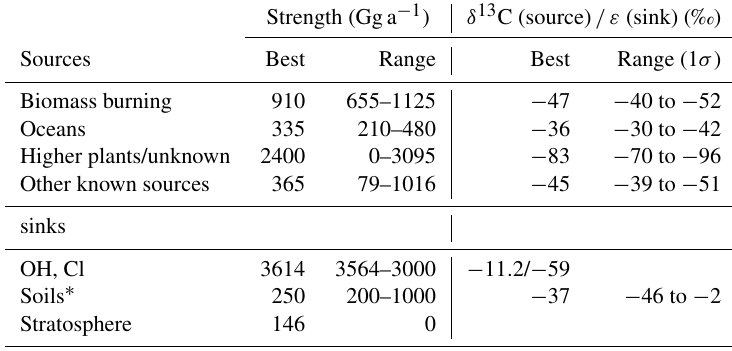
Table 4. Simplified CH 3 Cl source and sink scheme used in the model.